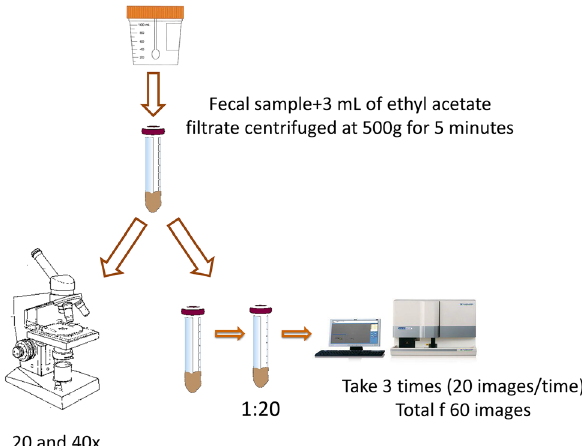
Figure 1. Flow chart of the total